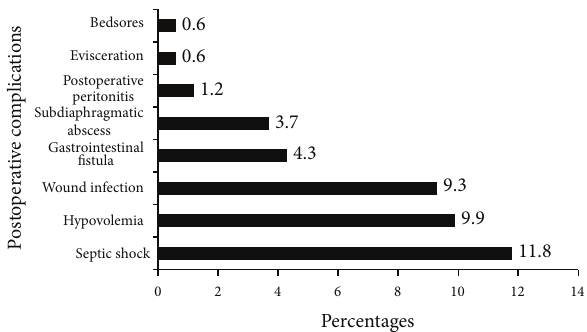
Figure 1: Frequencies and type of postoperative